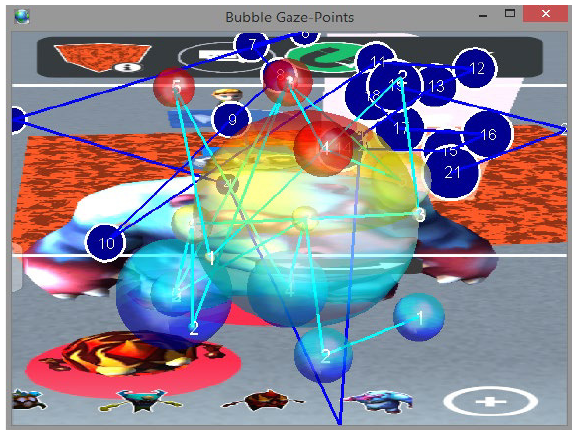
Fig. 4 Game narratives page with intense and stress mood of the user at